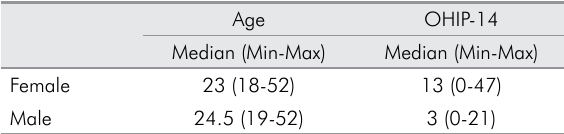
Table 1. Control Group profile.